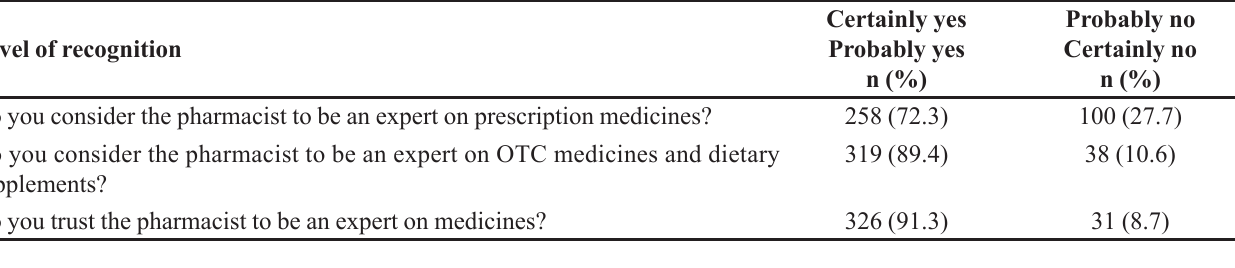
TABLE III - Recognition of the pharmacist as an expert on drugs (%; n = 357)